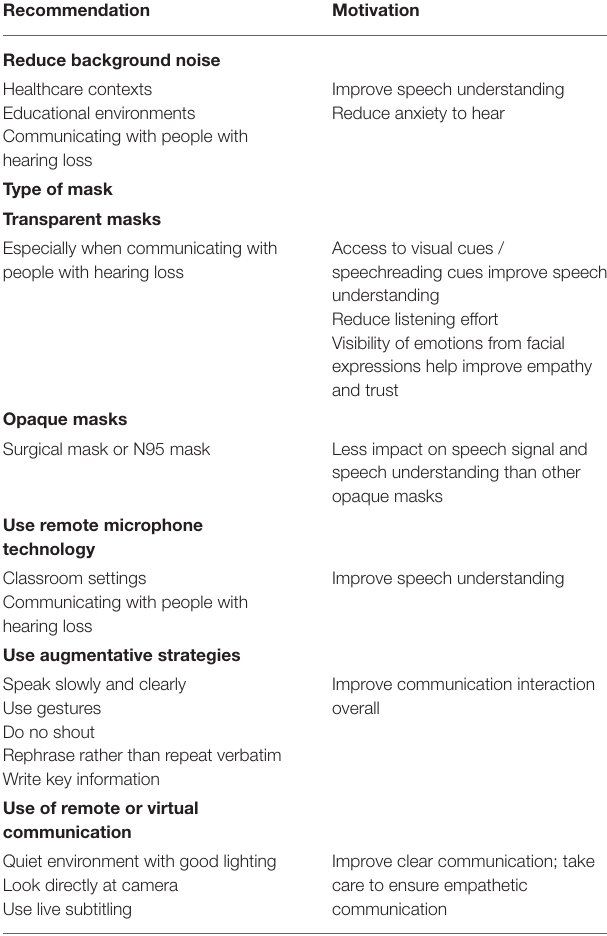
TABLE 2 | Clinical and educational implications from scoping review: key recommendations to lessen the impact of COVID-19 preventative measures on